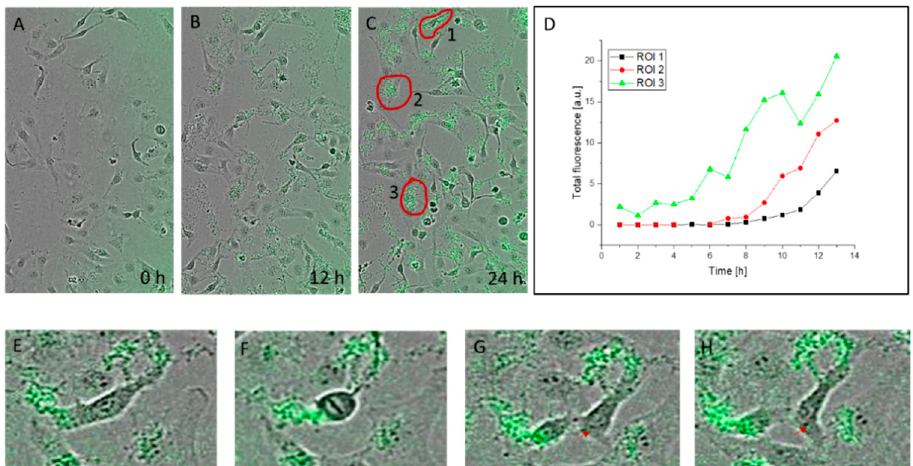
Figure 2. QD:Puf nanohybrid absorption by HeLa cells analyzed in real-time. The growth medium contained 10 nM Puf:QD. ( A – C ) are representative images of one spot, recorded before QD:Puf administration ( A ), after 12 h ( B ) and 24 h ( C ) of incubation with QD:Puf. Results of quantitative analysis of fluorescence changes in the region of interest (ROI) encircled in red in ( C ) are shown in ( D ). Note, that the green glimmer is a detection system artefact and was corrected during analysis. ( E – H ) show an example of a dividing cell with a clear indication of green fluorescence inheritance inside the cell interior (marked by a red arrow).